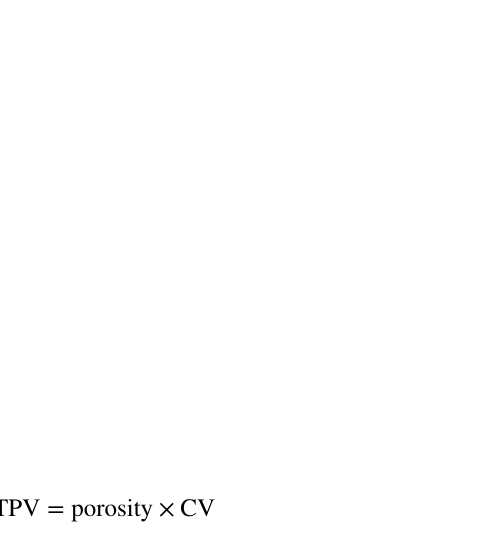
Table 4 Liquids and cores used in imbibition experiments